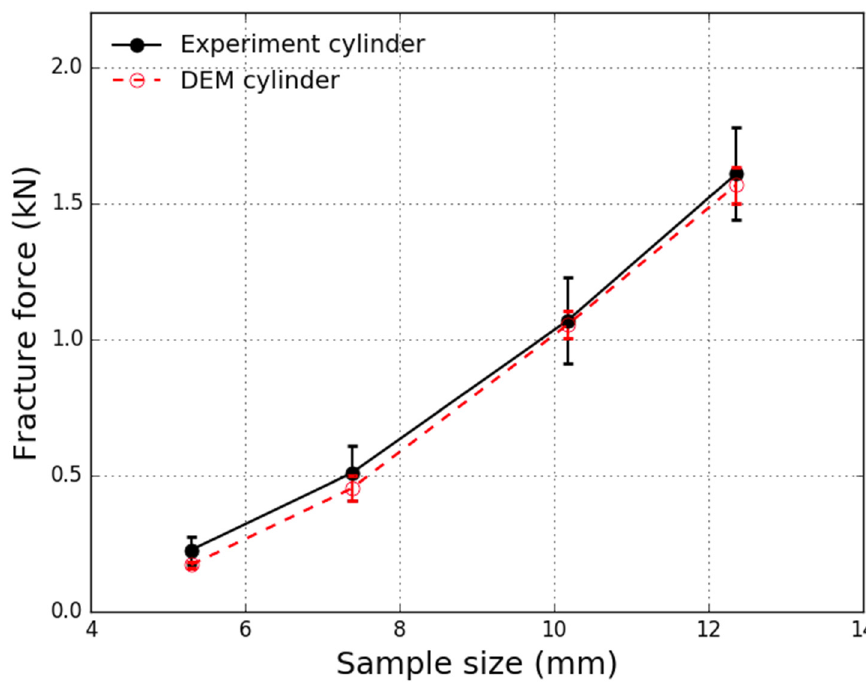
Figure 4. DEM fracture force predicted at different specimen sizes compared against experiment.